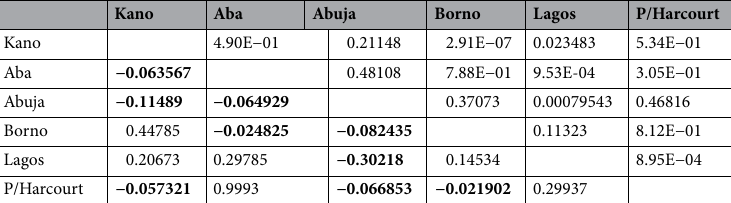
Table 4. Pearson correlation of selected locations. Significant values are in bold.